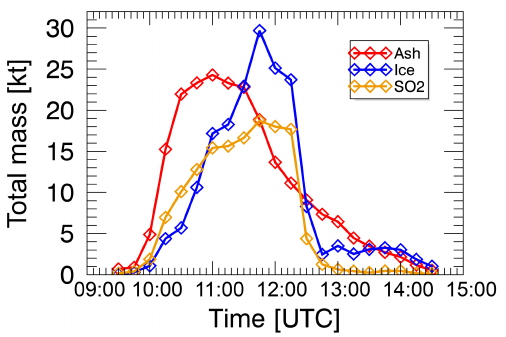
Figure 4. Ash, ice, and SO 2 mass time series retrieved from SEVIRI for the 23 November 2013 Etna